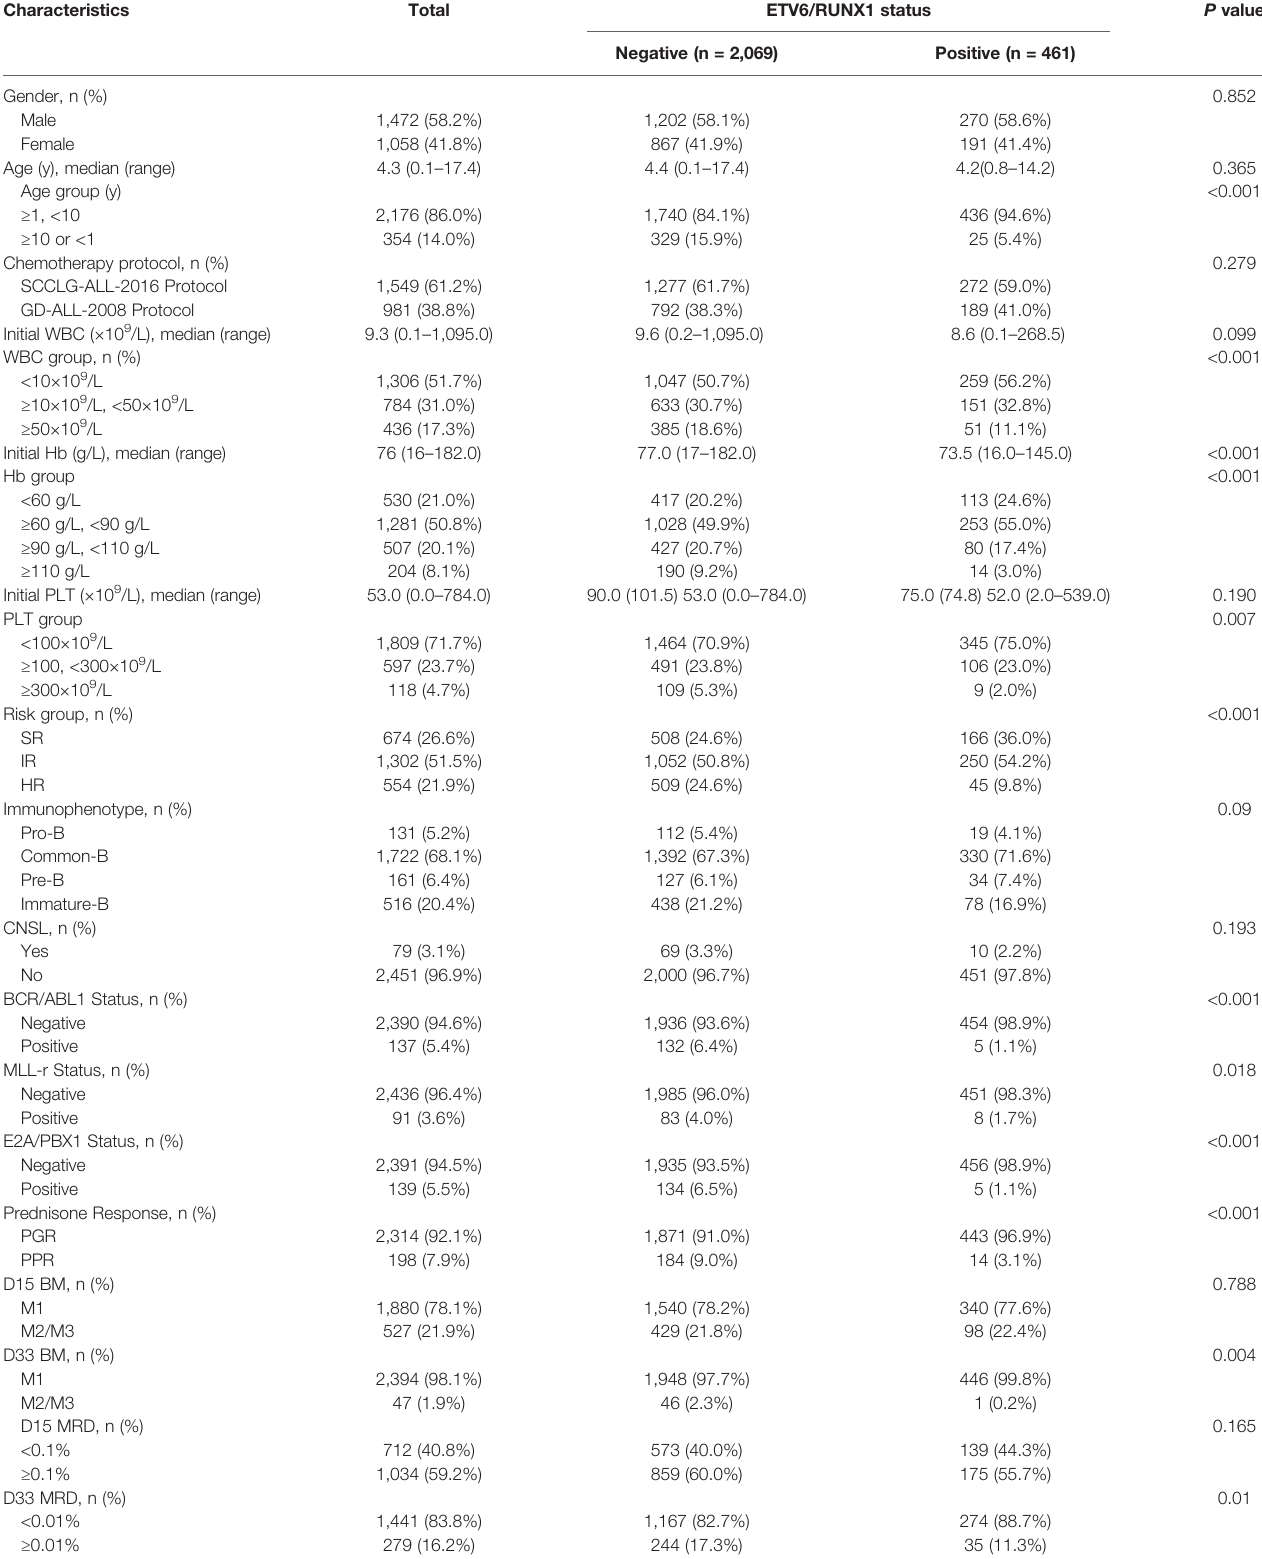
TABLE 1 | Baseline characteristics of study participants by ETV6/RUNX1 status classi fi cation.